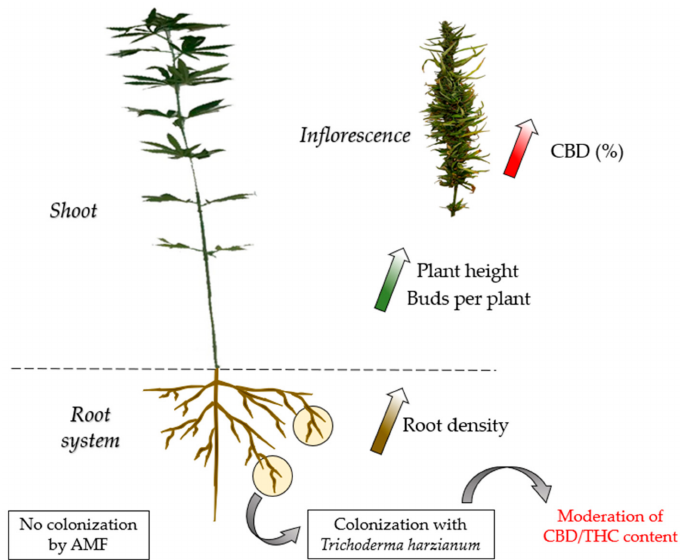
Figure 1. Positive impact of cannabis colonization with Trichoderma harzianum on three axes: root structure, vigor, CBD